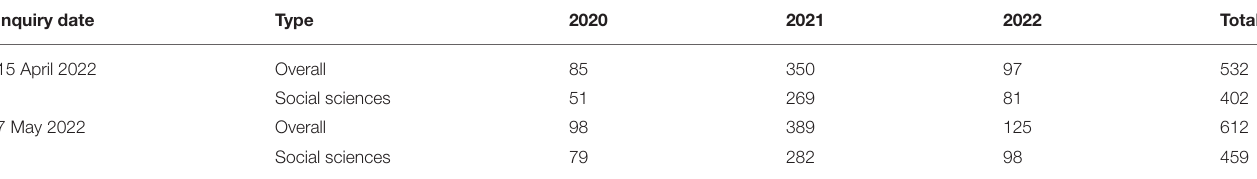
TABLE 1 | Summarized findings from the database inquiry in